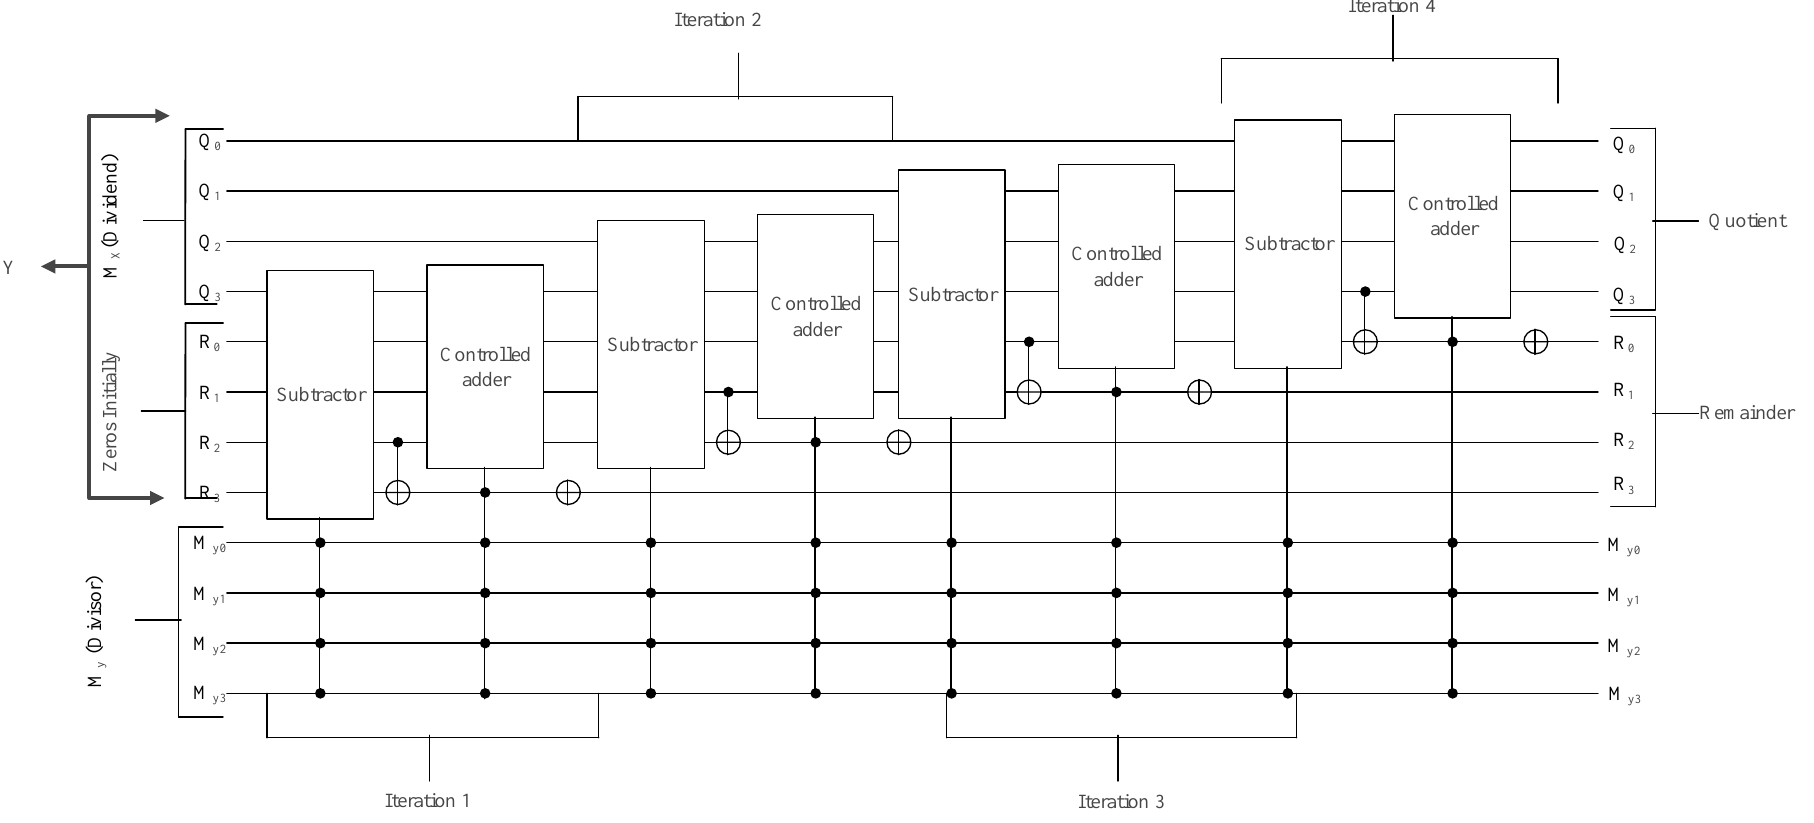
Figure 10. Quantum restoring division circuit for four qubit